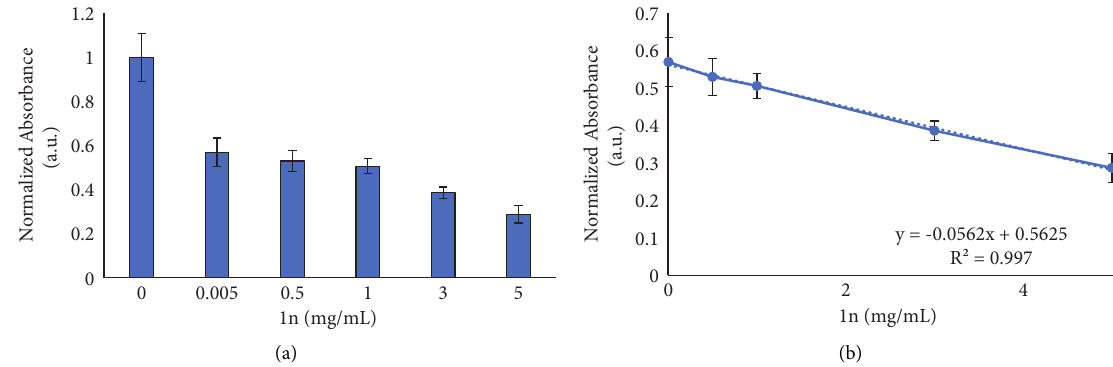
Figure 7: Decrease in NBTabsorbance versus progressive increase in 1n concentration (0–5mg/mL) (a) and 1n concentration that inhibits the NBTreduction rate by 50% (b). IC 50 calculation using linear regression analysis, employing five different concentrations of 1n . The data correspond to mean ± S.D. values from three experiments. Statistical analysis was performed using one-way ANOVA Tukey’s test (each group vs. Control). ∗∗∗ P < 0 . 0001. The results obtained indicate that compound 1n did not show growth inhibition against any strain, which means that 1n is not an antimicrobial agent.